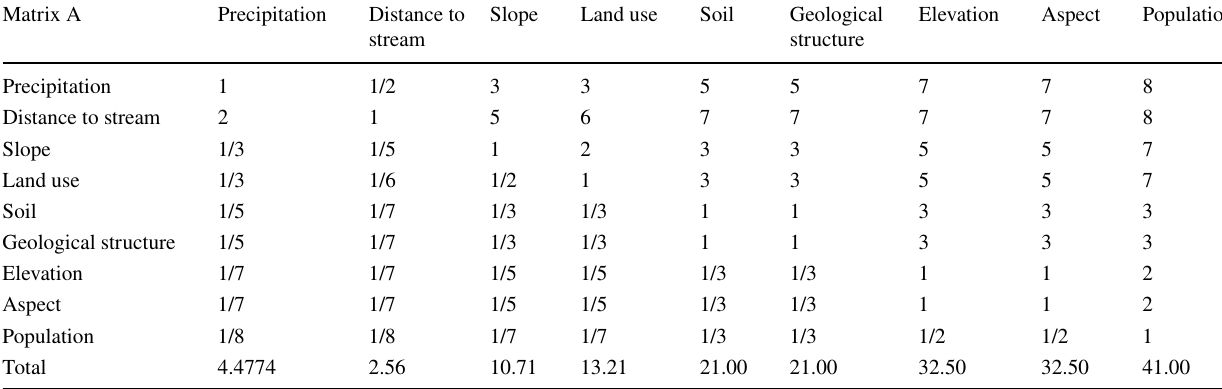
Table 4 The pairwise comparison matrix for flood risk of the region Matrix A